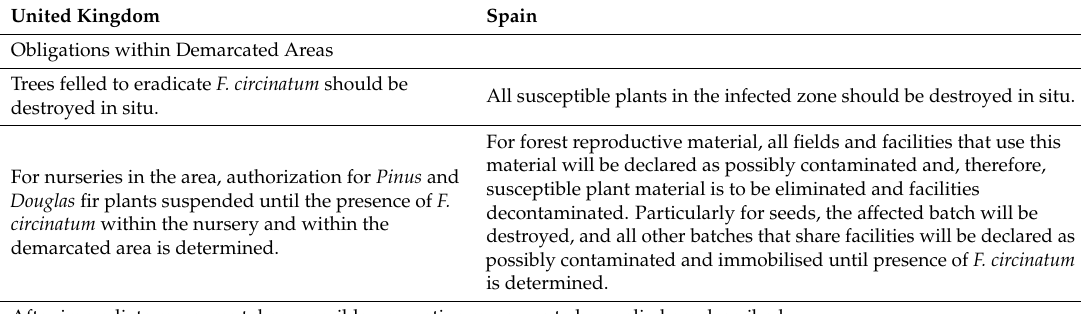
Table 3. Comparison of contingency plans of Fusarium circinatum as defined in United Kingdom [77] and Spain a